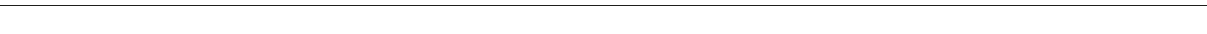
Fig. 1 Quantitative NO 3 − reconstruction and additional proxy records for sediment core M77/2 52-2 and comparison to different modeled NO 3 − budgets. a Pore density of Bolivina spissa and δ 18 O FORAM measured on Uvigerina peregrina (core M77/2 52-2). Error bars represent the standard error of the mean (1 SEM). Single data points represent mean pore density of 7 – 22 specimens (see Supplementary Table 1). b [NO 3 − ] BW calculated from the pore density of B. spissa after equation 4 and inverse δ 13 C FORAM measured on U. peregrina (core M77/2 52-2). Error bars represent 1 SEM including a complete error propagation (see equations 5 and 6). Magenta symbols: Model predictions from our 3D global biogeochemical model based on δ 15 N bulk for the location of M77/2 52-2. Gray line: Modern [NO 3 − ] M in the same water depth taken from the closest station available in the GLODAPv2 database 34 (Station see Methods). c Black: Relative changes of [NO 3 − ] BW calculated from the pore density of B. spissa (core M77/2 52-2) compared to modern [NO 3 − ] (indicated in b ). Error bars represent 1 SEM. Turquoise line: Modeled relative changes of global [NO 3 − ] based on global δ 15 N bulk records (modi fi ed after ref. 10 ; model run for strong water column denitri fi cation feedback) 10 . Magenta line: Relative changes of global dissolved inorganic nitrogen (DIN) predicted by the boxed earth system model from ref. 13 . Gray crosses: Record of relative [NO 3 − ] BW change based on the δ 13 C FORAM measured on U. peregrina (core M77/2 52-2) using equation 2. Blue triangle: Relative change of [NO 3 − ] at the intermediate Paci fi c between LGM (19 – 23 kyrs BP) and Late Holocene (0 – 6 kyrs BP). Relative [NO 3 − ] change was also calculated after equation 2 using the offset of mean δ 13 C FORAM measured on Cibicidoides spp. between the two time intervals in 14 sediment records from the Paci fi c. Error bars represent 1 SEM. Data has been taken from Petersen et al. 37 and two additional references 75,76 . See Methods section for location details and local variability. Magenta square: Model predictions from our 3D global biogeochemical model based on δ 15 N bulk for the location of M77/2 52-2 ( Δ LGM-Pre-Ind. : Offset between both time intervals from b ). d Record of δ 15 N bulk and accumulation rates of organic matter 52 in M77/2 52-2. The error bar is representing the standard deviation (2 σ ) of δ 15 N measurements on the reference standard